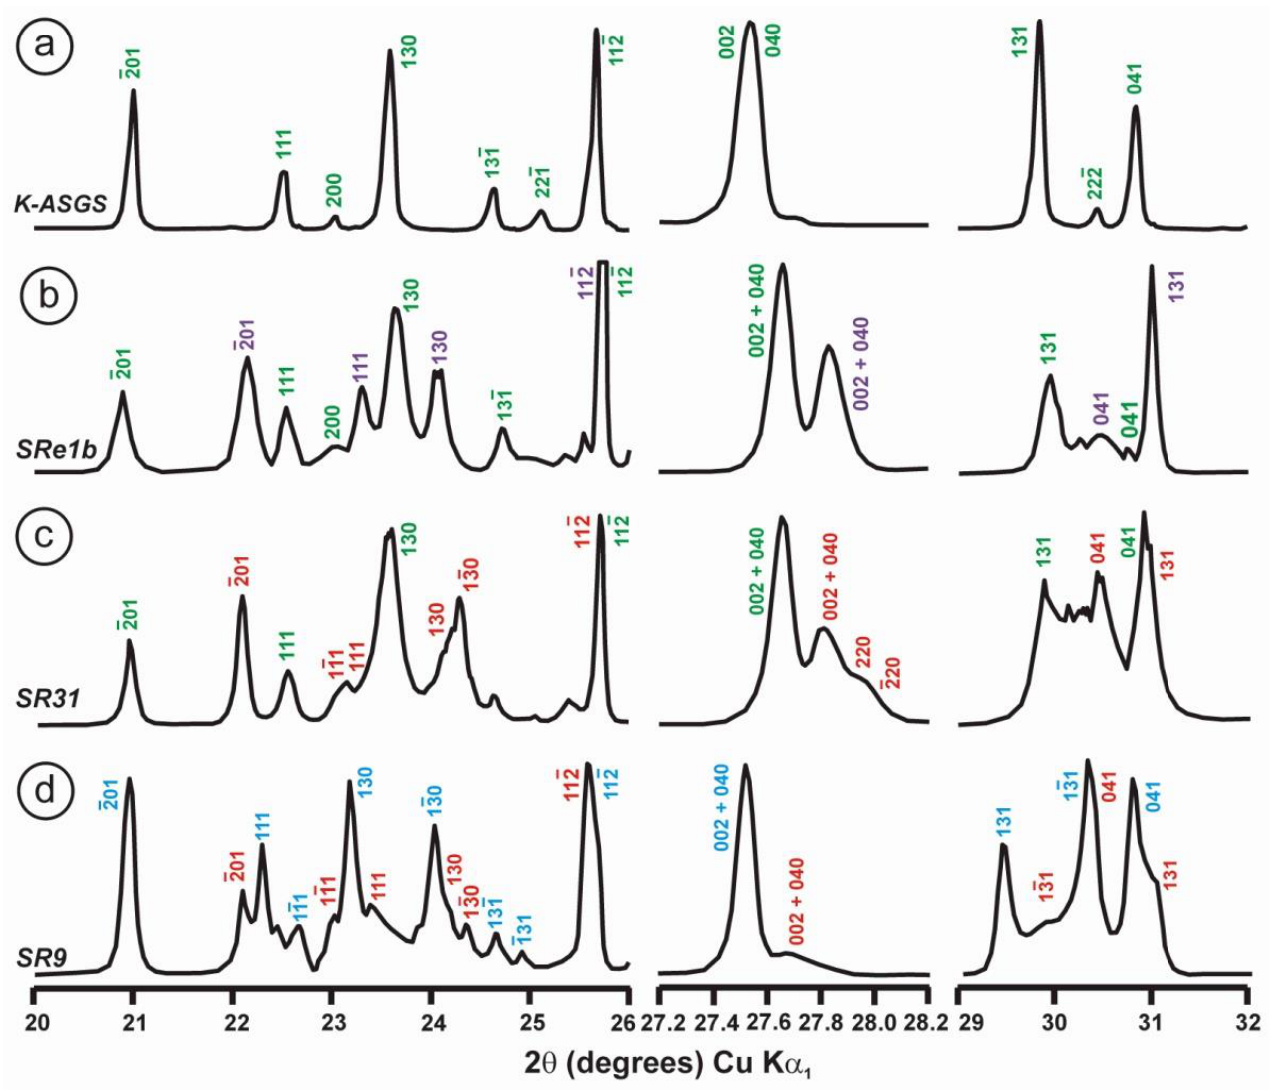
Figure 19. Powder XRD patterns of the moonstone specimens (SRe1b, SR31, SR9), compared to that of orthoclase in specimen K-ASGS, in three regions of the patterns, i.e., between 20 and 26 ◦ 2 θ , 27.2 and 28.2 ◦ 2 θ , and 29 and 32 ◦ 2 θ . ( a ) Specimen K-ASGS (Or 100 ) is an ion-exchanged sample from specimen ASGS as a precursor, with (hkl) peaks in green from a monoclinic C 2/ m space-group symmetry. ( b ) Specimen SRe1b has been indexed with (hkl) peaks from a monoclinic K-rich feldspar in green and from a monoclinic Na-rich feldspar in violet; the reflection (11 2̅ ) is shared by the two components, as it also is in specimen SR31. ( c ) Specimen SR31 has been indexed with (hkl) peaks from a monoclinic K-rich feldspar in green, and a triclinic Na-feldspar with low obliquity in red. ( d ) Specimen SR9 has been indexed with (hkl) reflections from two triclinic feldspars, in red for the Na-feldspar and in blue for the K-feldspar.